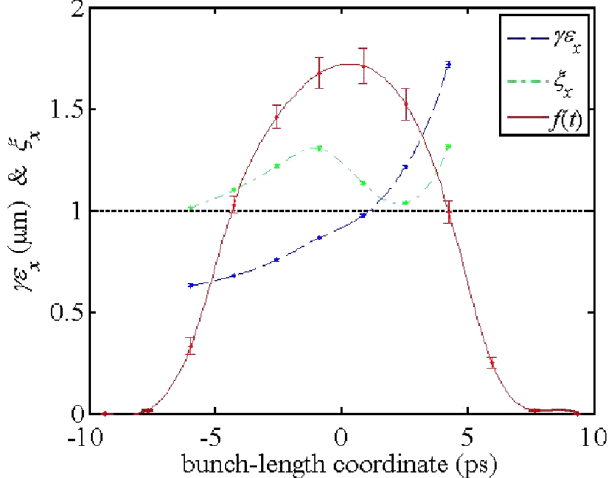
FIG. 28. (Color) The time-sliced horizontal emittance ( (cid:1)" in x in green), and temporal distribu- blue), mismatch parameter ( (cid:7) x tion [ f (cid:4) t (cid:5) in red, on arbitrary scale], for a 1-nC, 100-A bunch at 135 MeV, with emittance values < 1 (cid:2) m in the beam core and tail (bunch tail at